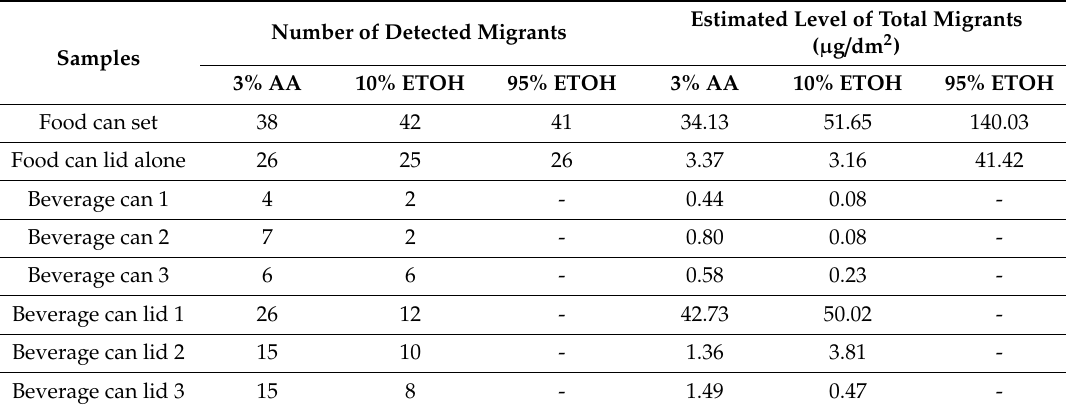
Table 1. Number of detected migrants and estimated concentration of total migrants from metal cans.